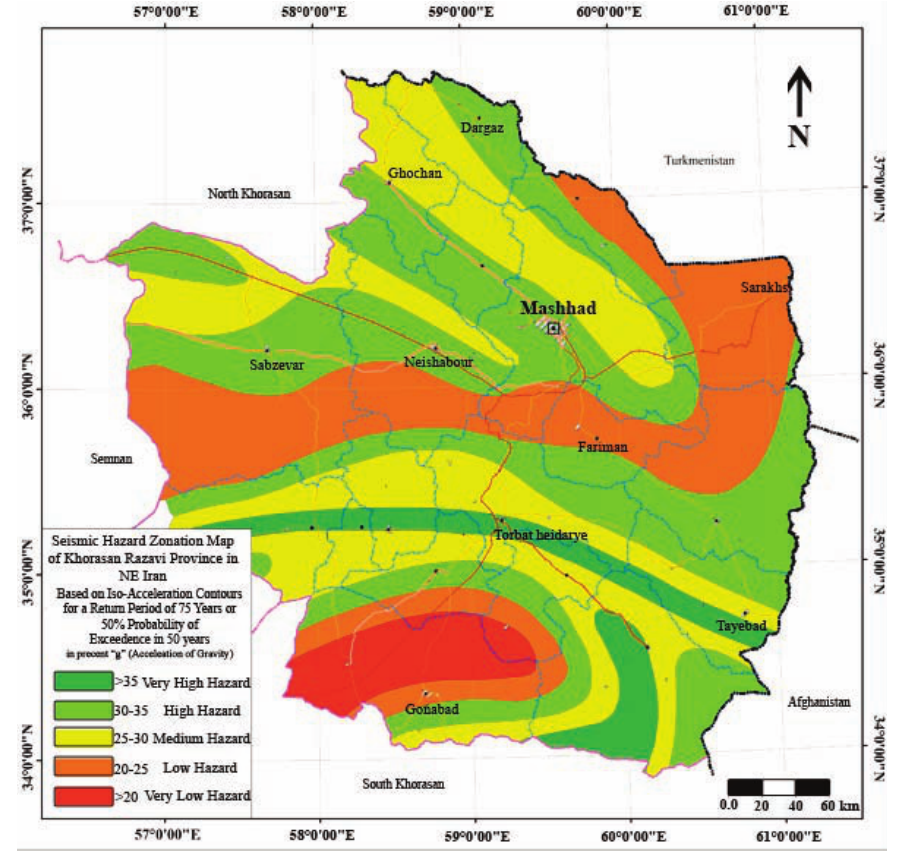
Figure 3. Seismic hazard zonation map of Khorasan Razavi province in north-eastern